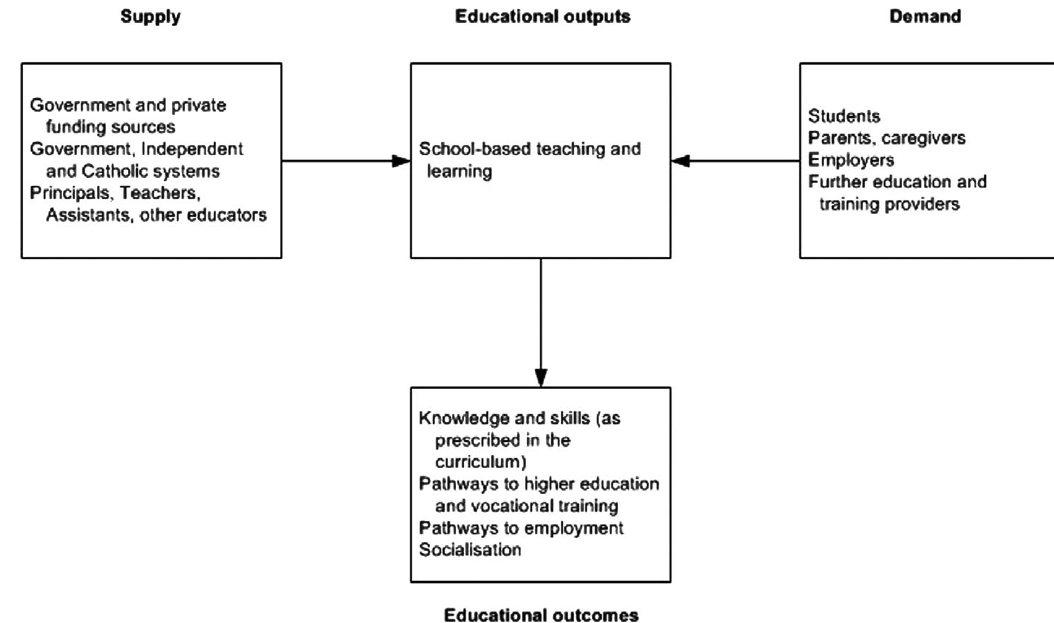
A frame of reference for advantage in the Australian education